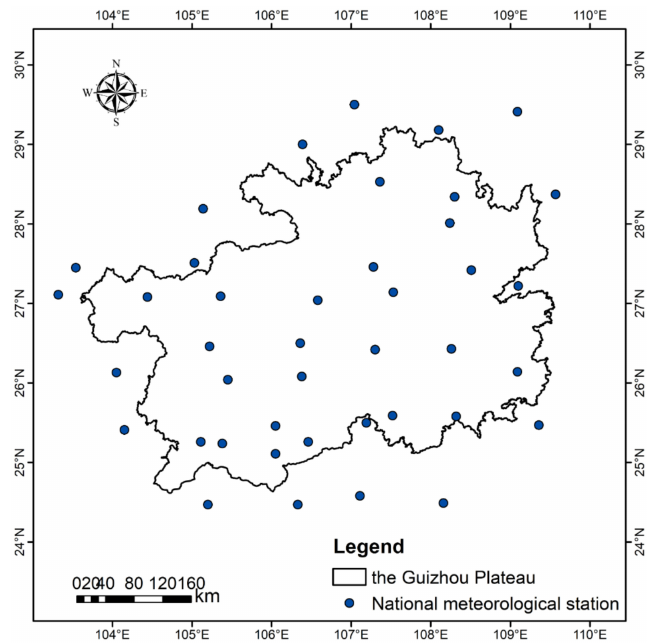
Figure 3. Distribution of the meteorological stations of the Chinese National Meteorological Information